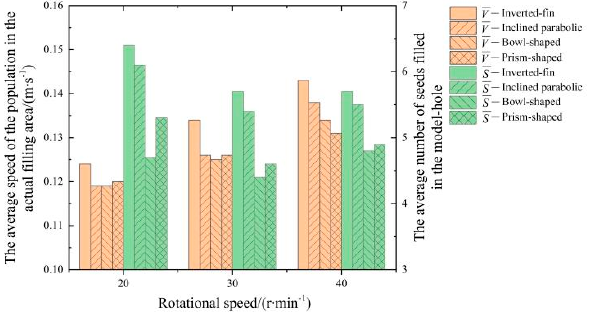
Figure 15. Effect of working speed on the average speed of the population and the average number of grains filled in the actual seed filling area of wheat.